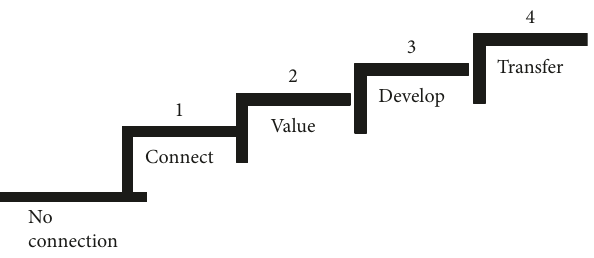
Figure 2: ABL Student Outcome Model (Stuhr et al.